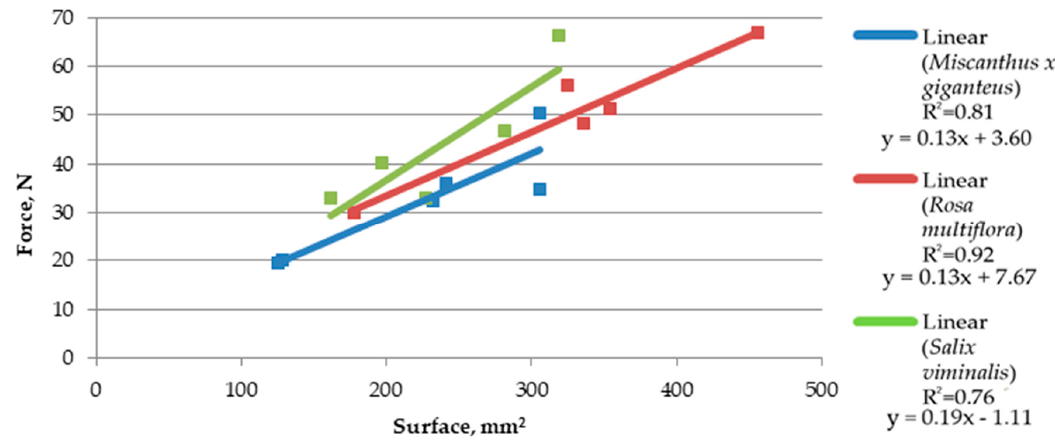
Figure 8. The average cutting force for the initial rotation speed n 2 = 3200 RPM.